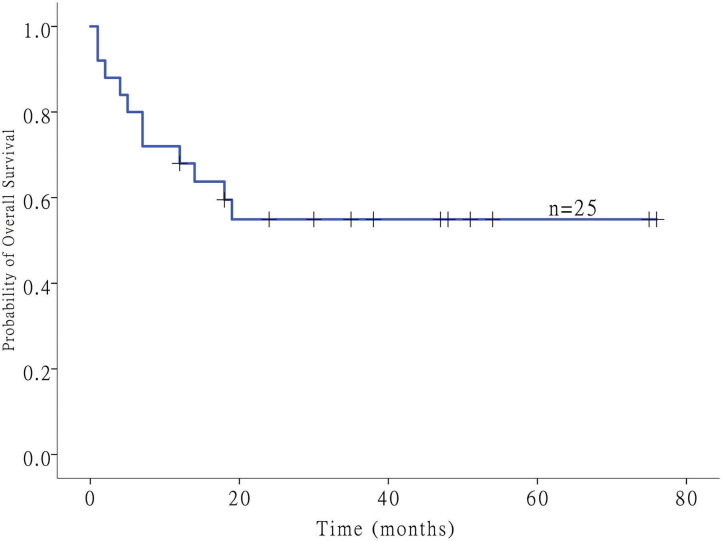
The Kaplan–Meier survival curve showed the overall survival in 25 patients with GI-DLBCL.